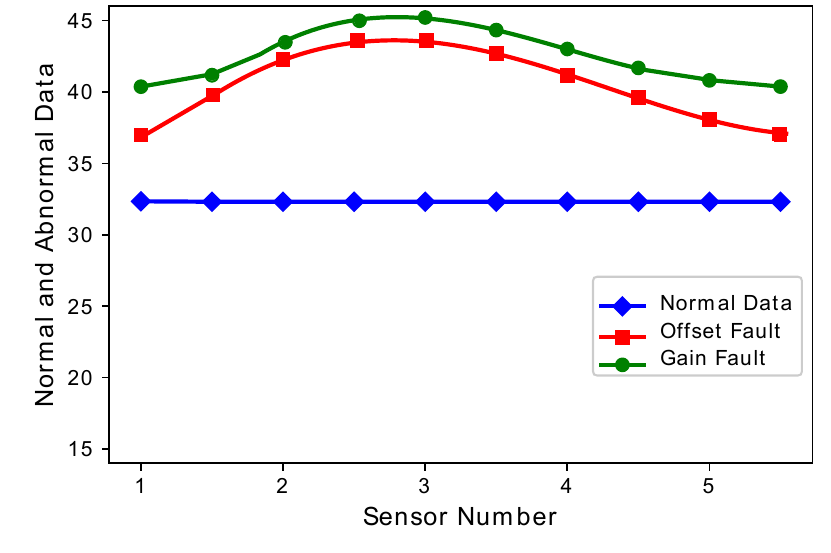
Figure 4. Normal and abnormal sensor data.